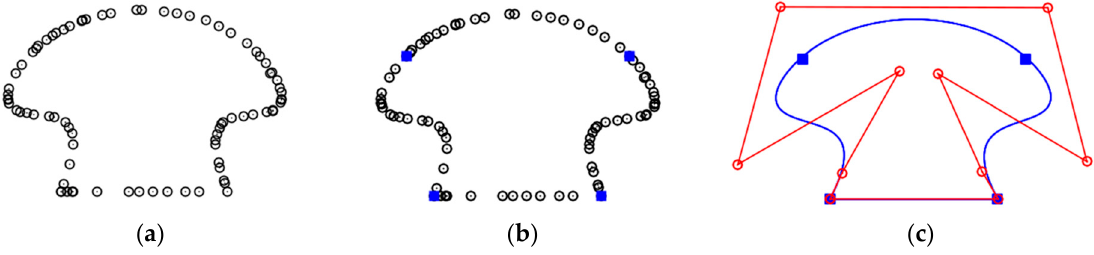
Figure 1. Contour modeling using changeable degree (CD)-spline. Boundary points ( a ), knot points (solid blue squares) ( b ), contour obtained using the CD-spline concept (blue line) and control points (hollow red circles) ( c )—adapted from Shen and Wang [25].